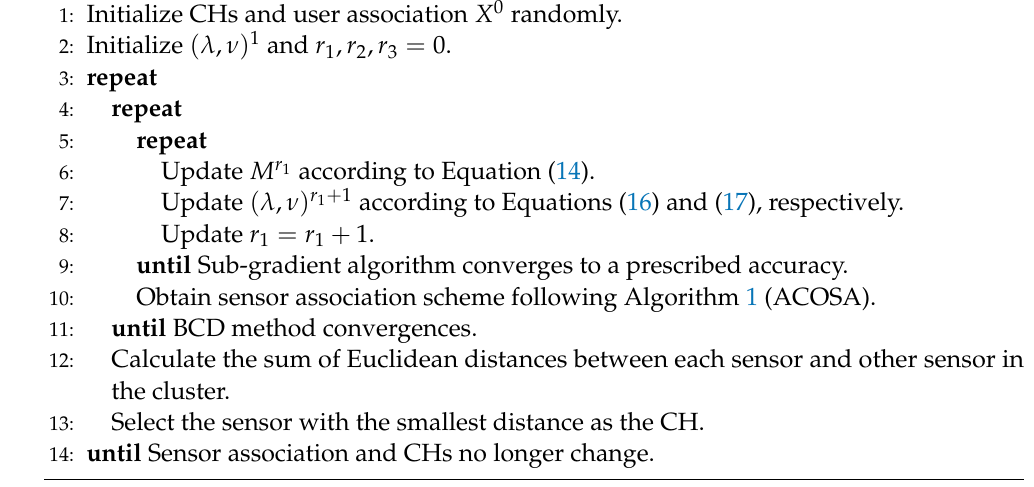
Algorithm 2 Data Collection and Topology Control based on ACO (DCTC)